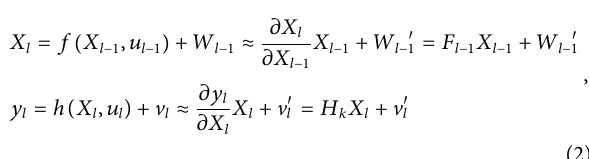
FIGURE 2 | OCV – SoC dataset tested at three ambient temperatures. (A) 0 ° C; (B) 10 ° C; (C) 20 ° C.